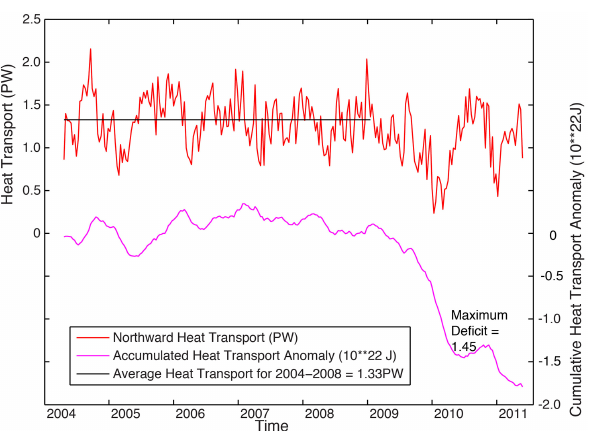
Figure 3. Accumulated northward heat transport deficit during the Rapid event starting in April 2009. Normal AMOC heat transport is defined as the average heat transport for the first 5 years of the array, April 2004 to December 2008, after removing a seasonal cy- cle in heat transport. The anomaly transport at each time is defined as the difference between the instantaneous transport and the “nor- mal” transport. Anomalous heat transport is then accumulated over time and a local maximum accumulated heat transport deficit of 1 . 45 × 10 22 J is achieved in June 2010.